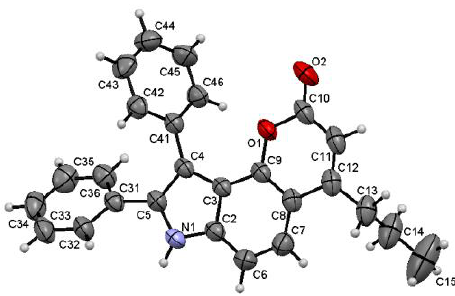
Figure 2. X-ray crystal structure of pyrano[2,3- e ]indole 6b (CCDC 2152277 ).